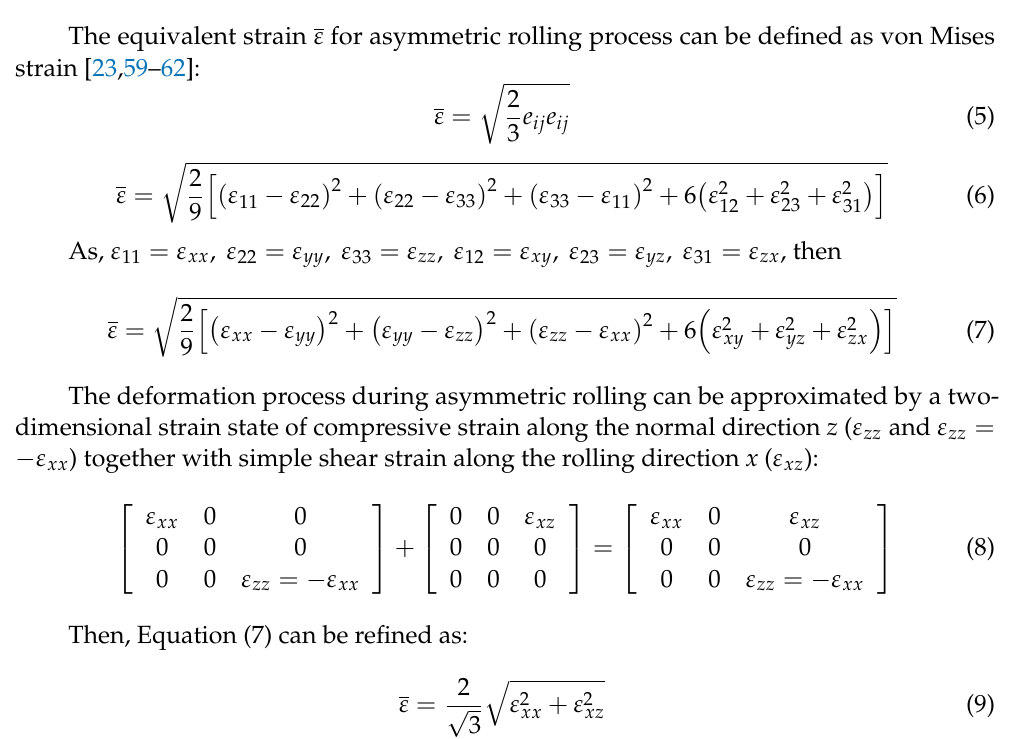
Figure 25. Results of FEM simulation (this work) of simultaneous pure and simple shear during asymmetric rolling ( a ) and rotation of the axes of the strain ellipsoid when passing through the deformation zone ( b ) (simulation conditions: room temperature, material AA5083, initial sheet thickness 1.0 mm, thickness reduction 60%, diameters of work rolls 500 mm, Coulomb friction coefficient 0.4, speed of the bottom work roll 43 mm/s, speed of the top work roll 100 mm/s, FEM code DEFORM